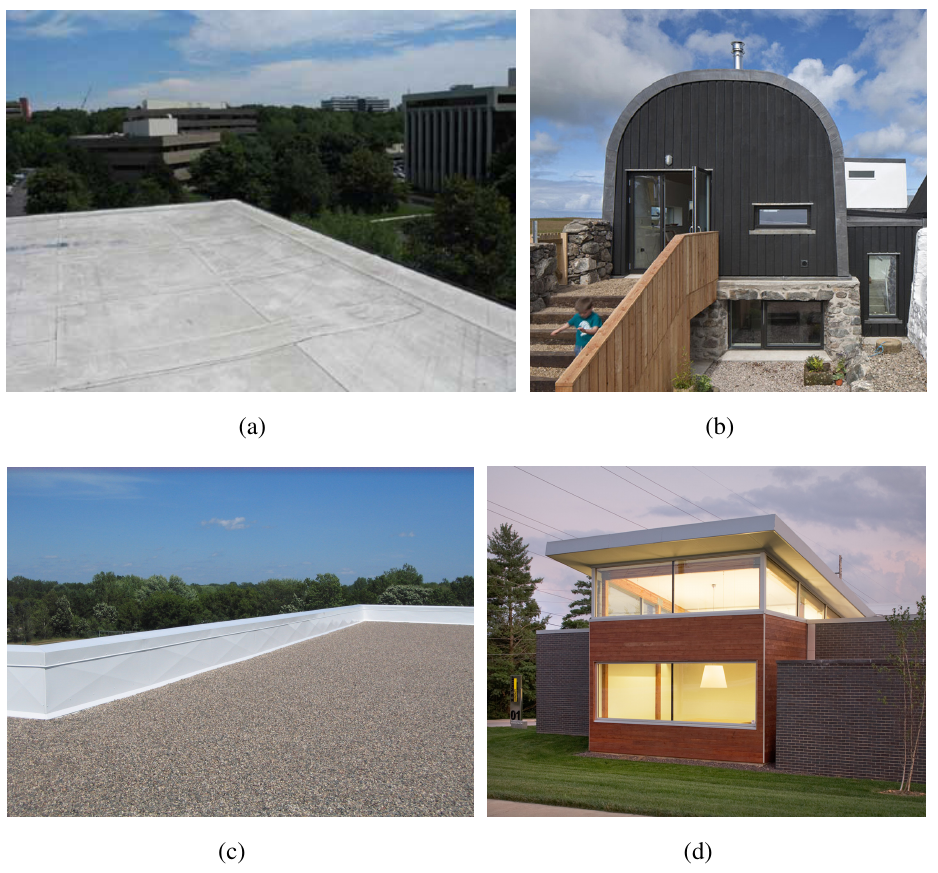
Figure 14. Examples of the different roof edges tested. ( a ) Simple edge; ( b ) curved edge; ( c ) railing; ( d ) cantilever.